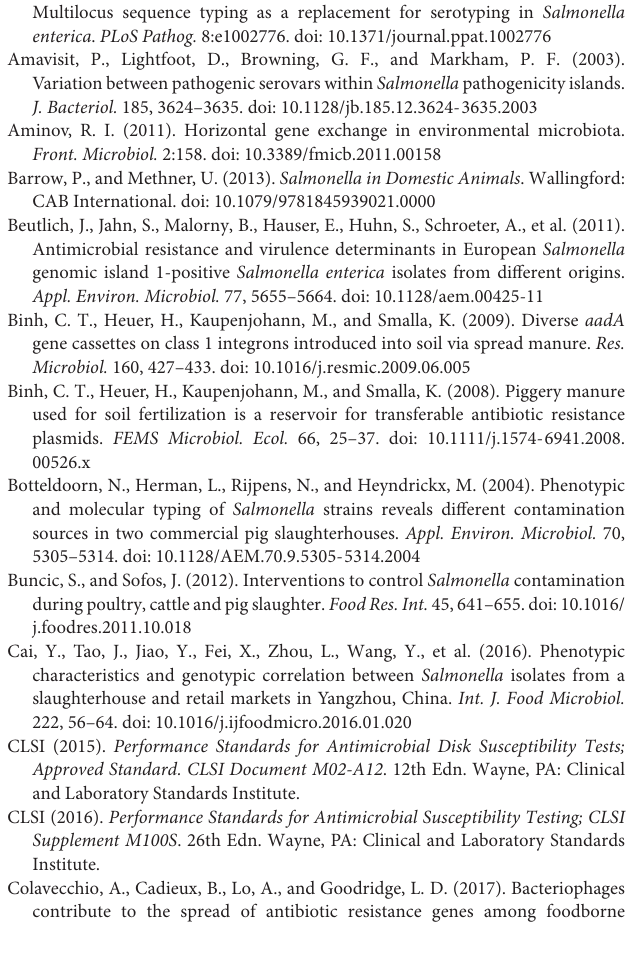
TABLE S1 | Strains information. Sheet 1: Epidata, sample ID, NCBI accession number, genome deep coverage, and breadth. Sheet 2: repartition of the selected